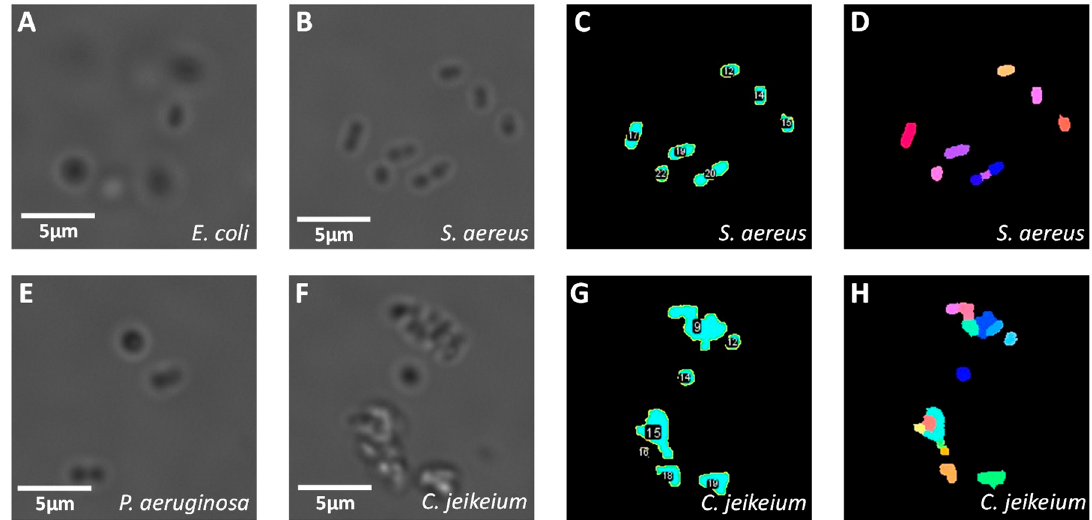
Figure 3. Results of image processing for acquisitions made in PBS. ( A , B , E , F ) are respectively zoomed images of E. coli , S. aureus , P. aeruginosa and C. jeikeium . ( C , G ) are the binary masks used to identify and label objects in ( B , F ), respectively. ( D , H ) are the labelled images computed by the declustering algorithm. Colours are arbitrarily chosen and indicate what the algorithm identifies as objects (i.e., individual bacterium or clusters) in ( C , G ), and as items (individual bacterium), whether it belongs to a cluster or not, in ( D , H ). Scale bars: 5 µm.